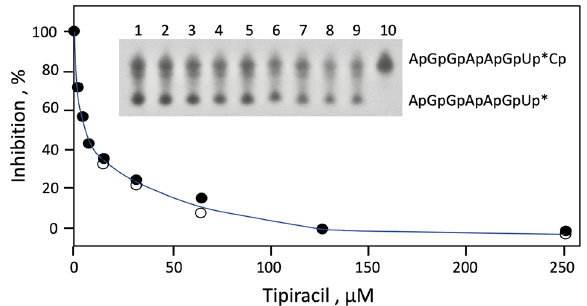
Fig. 2 Inhibition of SARS-CoV-2 Nsp15 endoribonuclease by Tipiracil. RNA heptamers (5 ′ AGGAAGU), labeled at their 3 ′ ends with 3 ′ ,5 ′ -[5 ′ - 32 P] bisphosphates to form octamers 5 ′ AGGAAGU 32 pCp, were incubated at 30°C with Nsp15 in the presence of Tipiracil at 0, 1.85, 3.9, 7.8, 15.6, 31.25, 62.5, 125.0, and 250 μ M (Lanes 1 – 9). Lane 10: minus enzyme control. Reaction products were separated in a 20% polyacrylamide gel containing 7 M urea. 32 P -labeled phosphates are marked with an asterisk. Raw image of the gel is shown in Supplementary Fig. 2. The x- and y-axes are plotted on a linear scale. Points represent two independent assays (black and open circles). Raw data for Fig. 2 are included in Supplementary Data fi le. The continuous line represents the best fi t for the Morrison equation 46